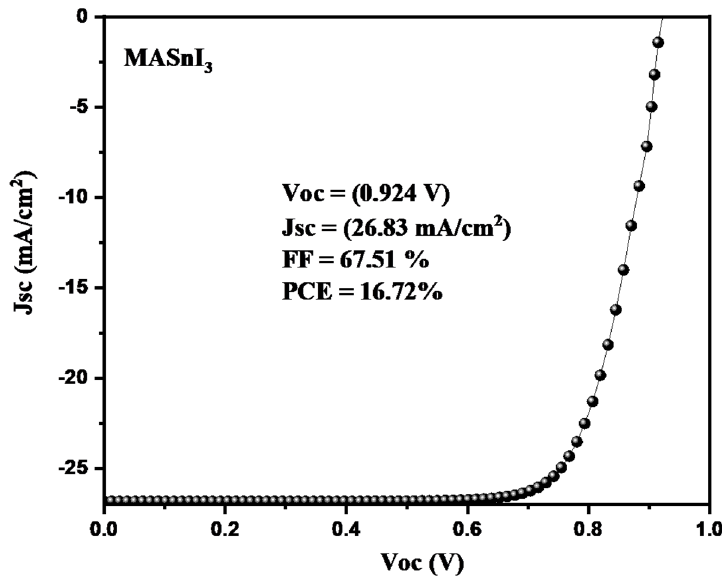
Figure 6. J-V graph of reference device (TiO 2 /MASnI 3 /spiro-OMeTAD) [29]. Figure 6. J ‐ V graph of reference device (TiO 2 /MASnI 3 /spiro ‐ OMeTAD) [29]. Table 1. Comparison of performance of simulated NH 3 (CH 2 ) 2 NH 3 MnCl 4 -based PSCs with recently published simulated work